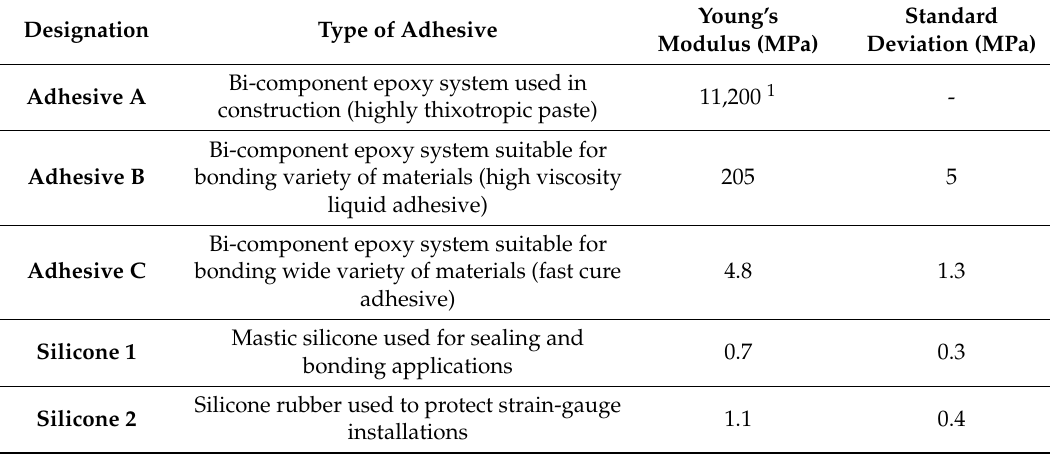
Table 2. Young’s modulus of the di ff erent adhesive systems used in the experimental